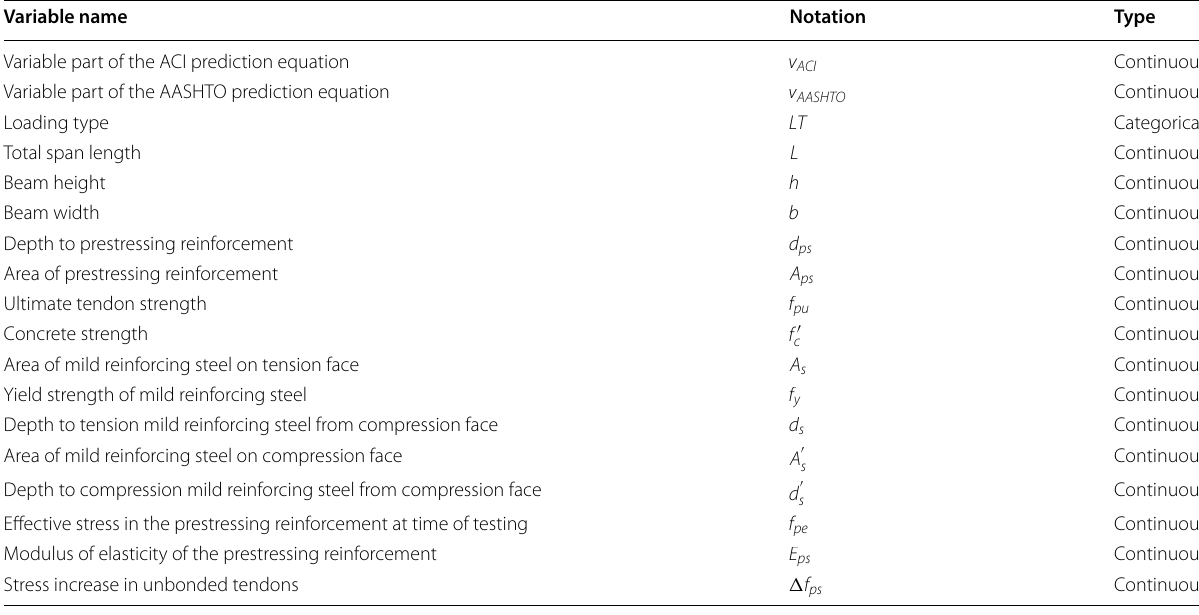
Table 1 Variable names and descriptions for the statistical